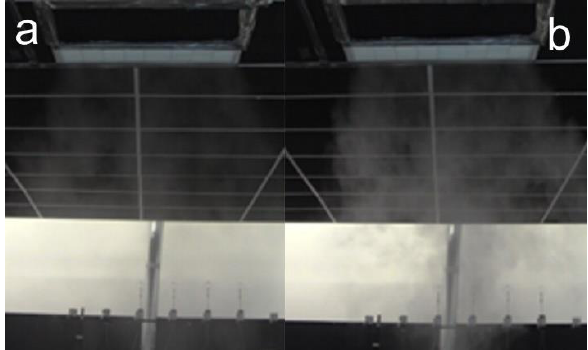
Fig. 5 . Smoke test of the NSAL diffuser, with outflow directed downwards, for two air streams: (a) - 120 m 3 /h, (b) - 480 m 3 /h.